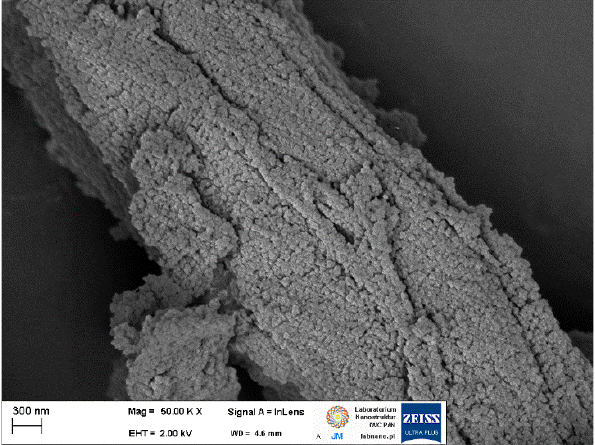
Figure 3. SEM image of small-sized UiO-66-type crystallites of MOF deposited on the cellulose fibre.